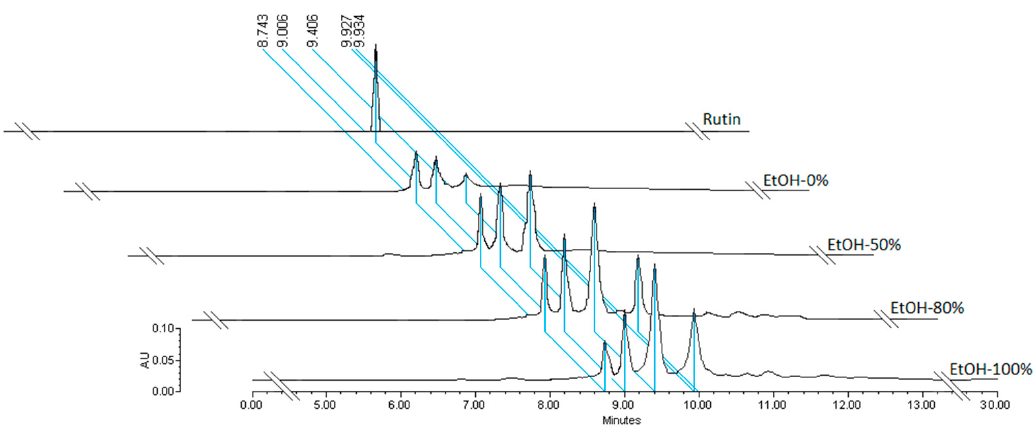
Figure 2. HPLC of Rutin. Chromatographic profile of the routine concentration curve (standard) and extracts of EtOH-0%, EtOH-50%, EtOH-80%, and